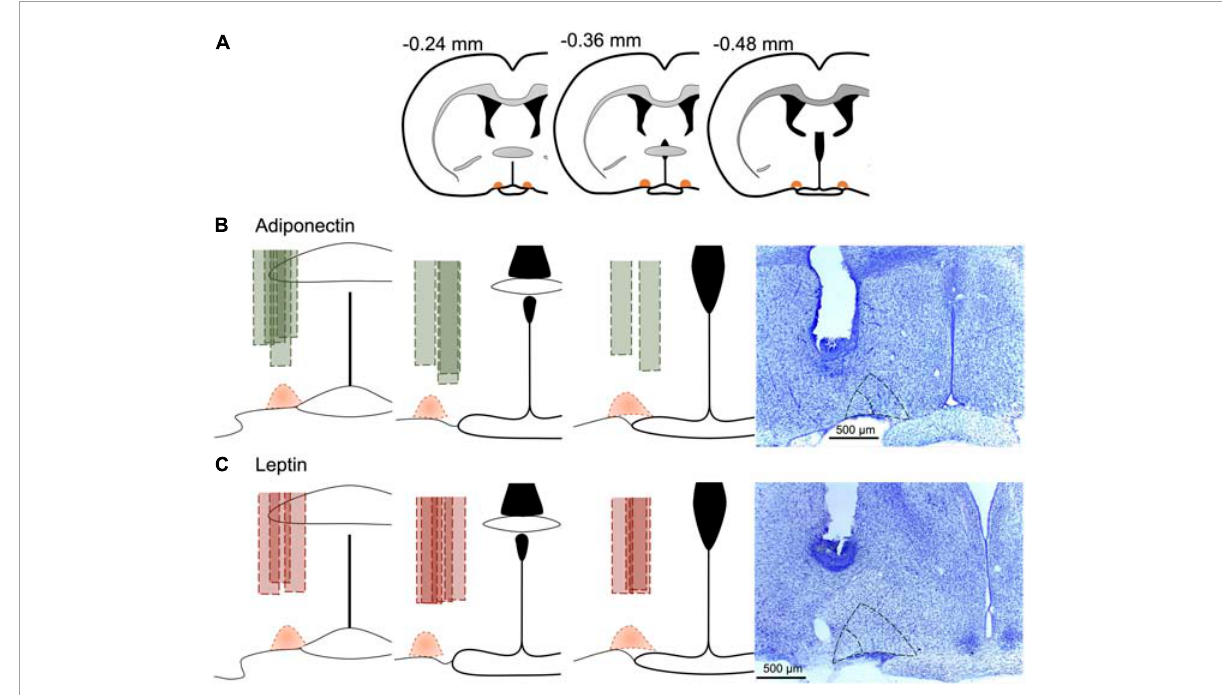
FIGURE2 Cannula position in experimental animals. (A) Schematic representation of the anteroposterior reference of VLPO, and the site of the cannula in each animal included for (B) adiponectin in green or (C) leptin in red. Dotted area in orange represents the VLPO extension as described in the brain atlas (Paxinos and Watson, 2007). Representative images at the right for the site of the cannula for each adipokine, core VLPO is represented within the inner dotted triangle, while the bigger dotted triangle include the extended VLPO. Brains were stained with cresyl violet for better